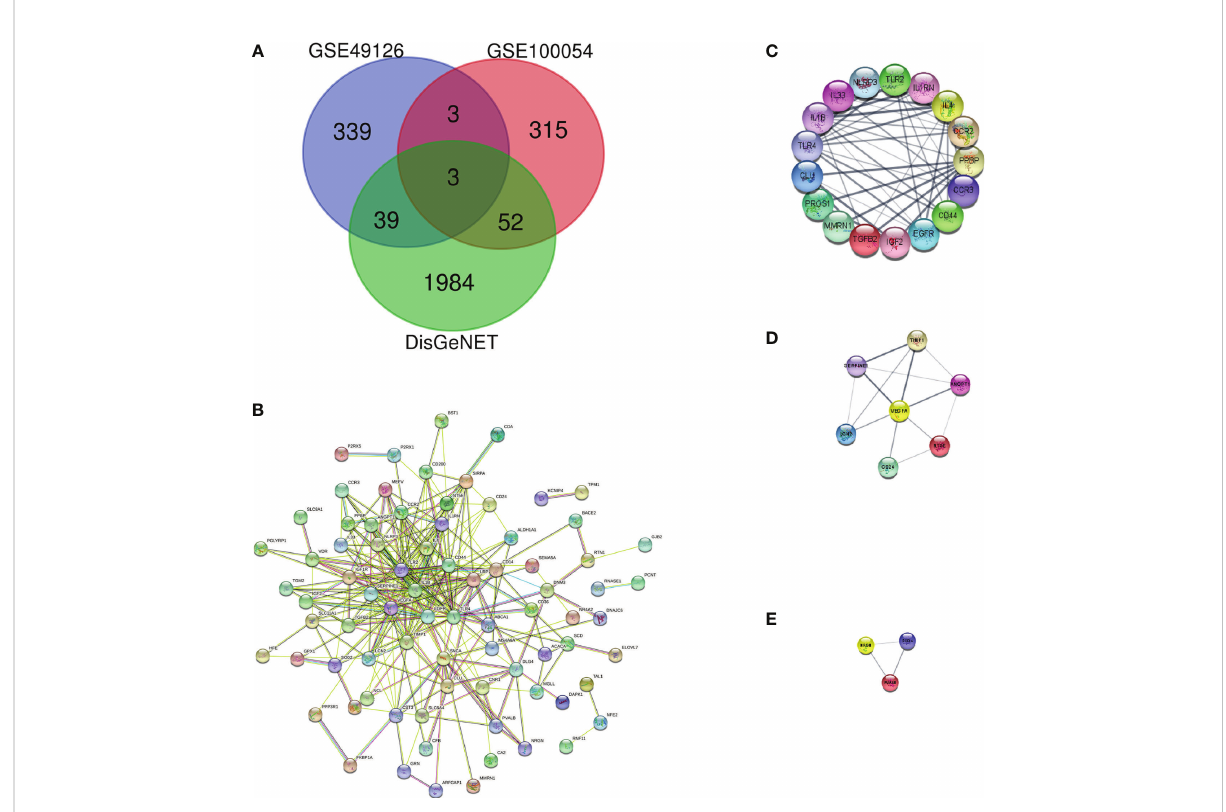
FIGURE 3 Protein – protein interaction network and key protein expression module. (A) Venn diagram of DEGs in GSE100054, GSE49126 gene chips and genes from DisGeNET; (B) Protein – protein interaction network of DEGs; (C) Key protein expression module 1; (D) Key protein expression module 2; (E) Key protein expression module 3. The nodes represent genes, and the edges represent links between